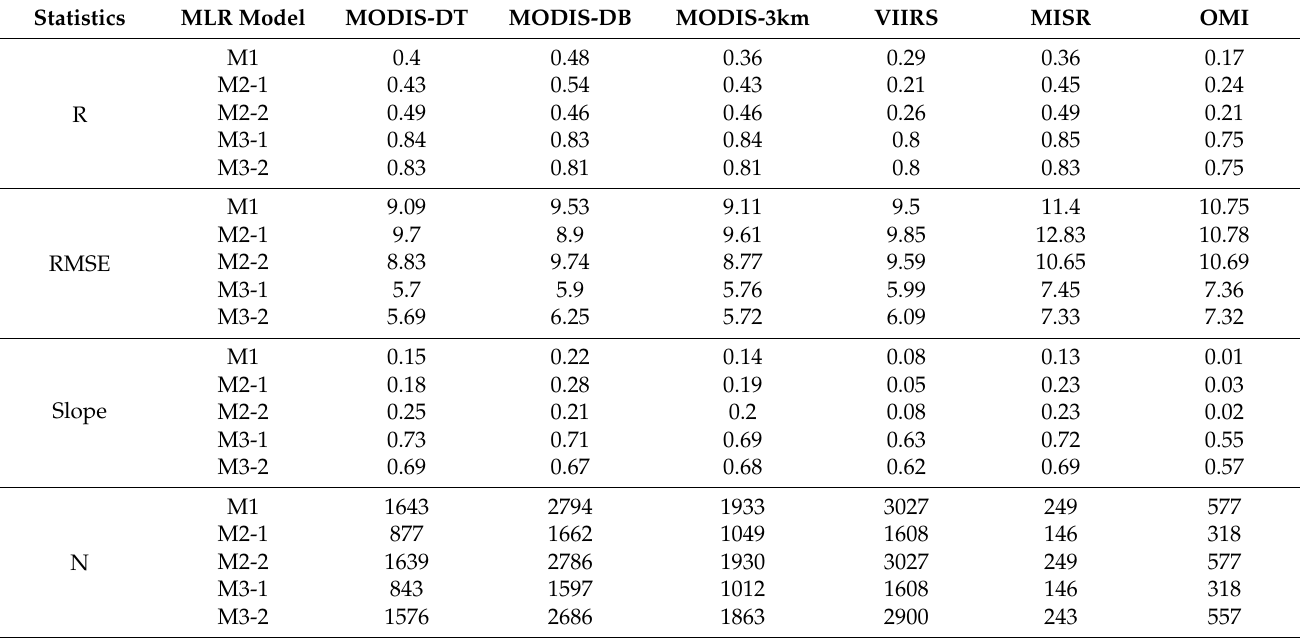
Table 4. R, RMSE, slope, and used data number (N) of correlations between measured and estimated PM 2.5 (unit: µ g/m 3 ) values for five MLR models (M1, M2, M2-1, M3-1, and M3-2) using six satellite AODs. The unit of RMSE is µ g/m 3 .